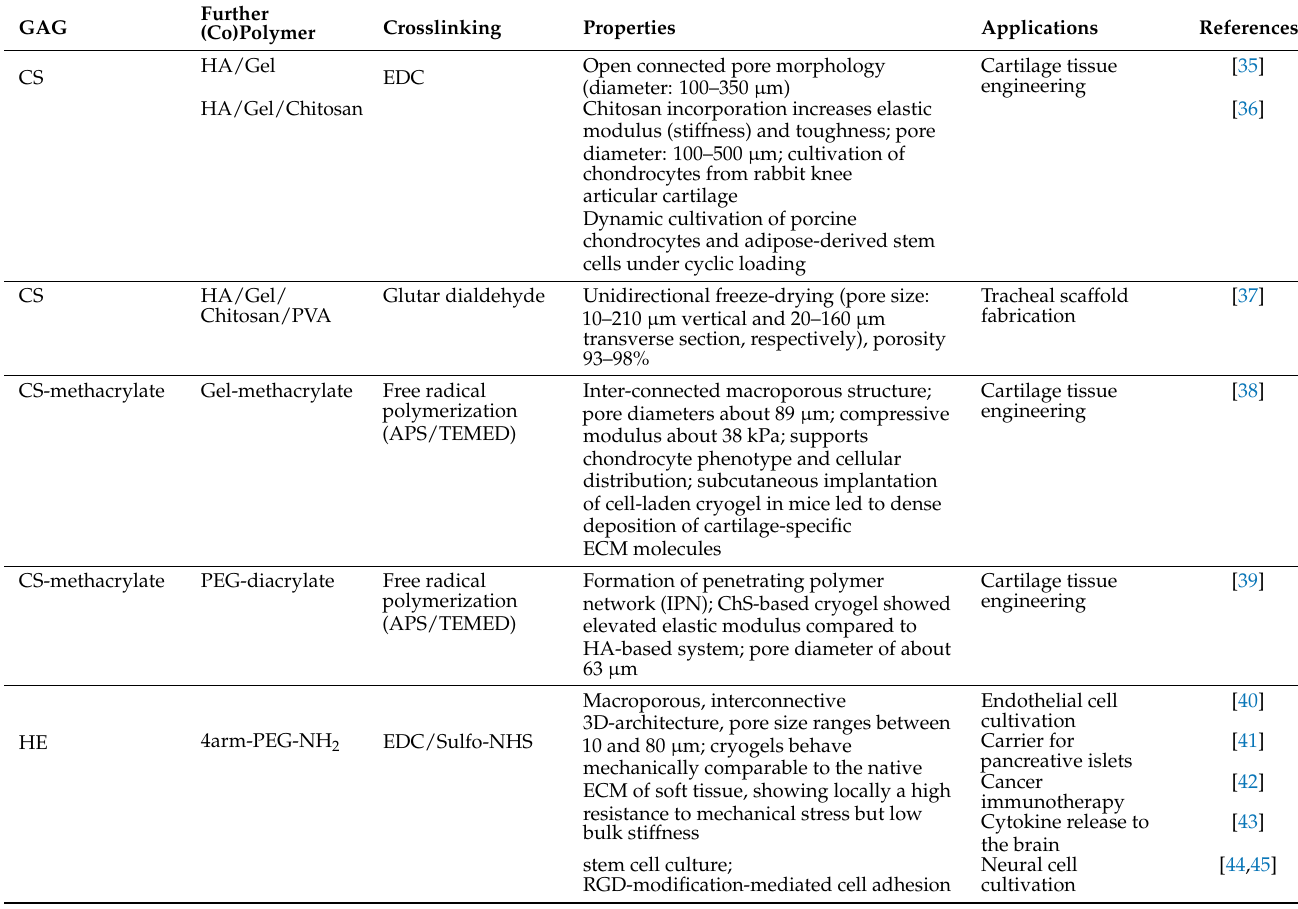
Table 2. Overview on relevant publications using chondroitin sulfate (CS)- and heparin (HE)-based cryogels. Further GAG